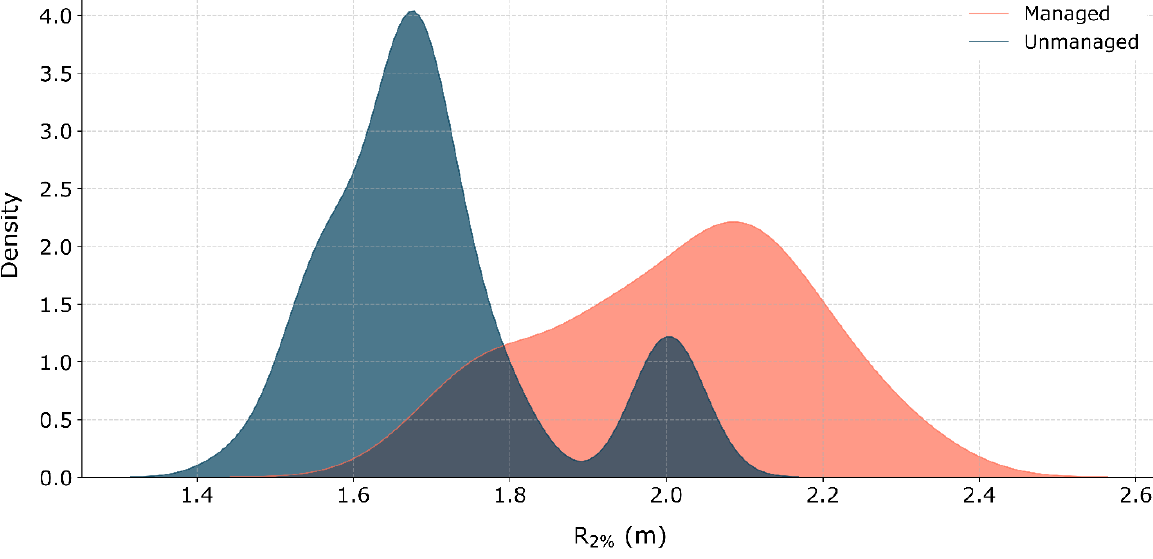
Figure 9. Run-up magnitude (as measured by R 2% ) arranged according to representative profile management regime. Mean kurtosis values for the unmanaged and managed profiles were 0.42 and −0.73, respectively. Mean skewness values for the unmanaged and managed profiles were 1.00 and −0.73, respectively.